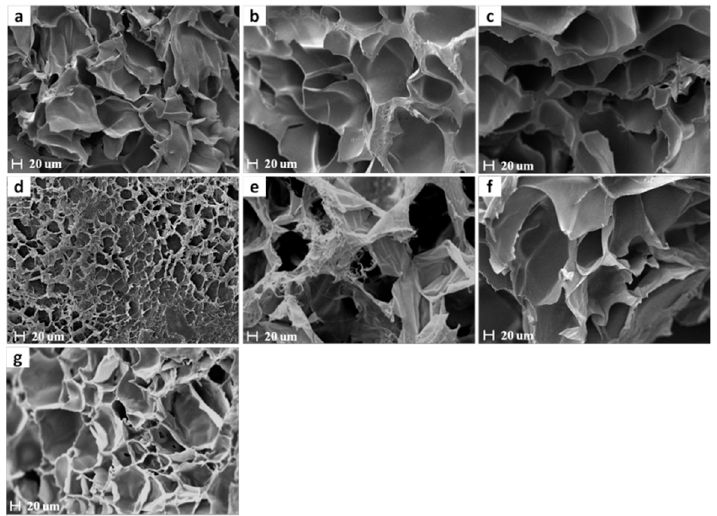
Figure 4. SEM images of hydrogels with ( a ) NaCl, ( b ) CaCO 3 , ( c ) NaHCO 3 , ( d ) PEG2000, ( e ) carbamide, ( f ) PVP, or ( g ) no pore-forming agents.